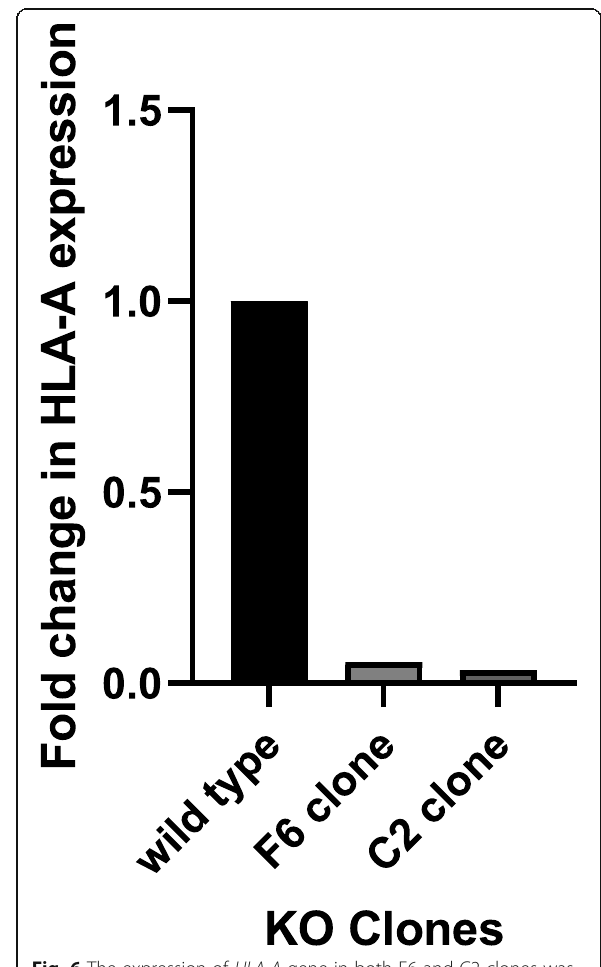
Fig. 6 The expression of HLA-A gene in both F6 and C2 clones was reduced significantly after HEK293T cells were transfected with PX458-A-gRNA1- and PX458-A-gRNA3-targeting CRISPR/Cas9